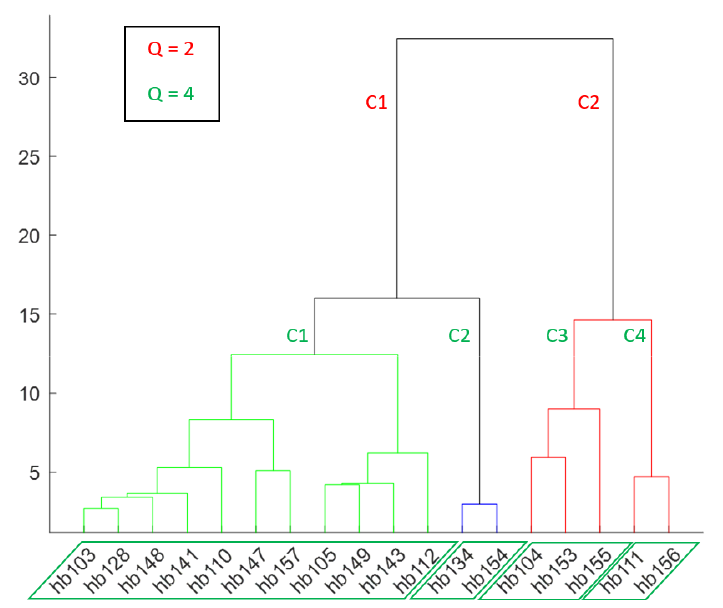
Figure 9. Dendrogram of the agglomerative hierarchical clustering for the suburban environment at the weekend. Clustering solutions for Q = 2 (in red) and Q = 4 (in green) are also highlighted.